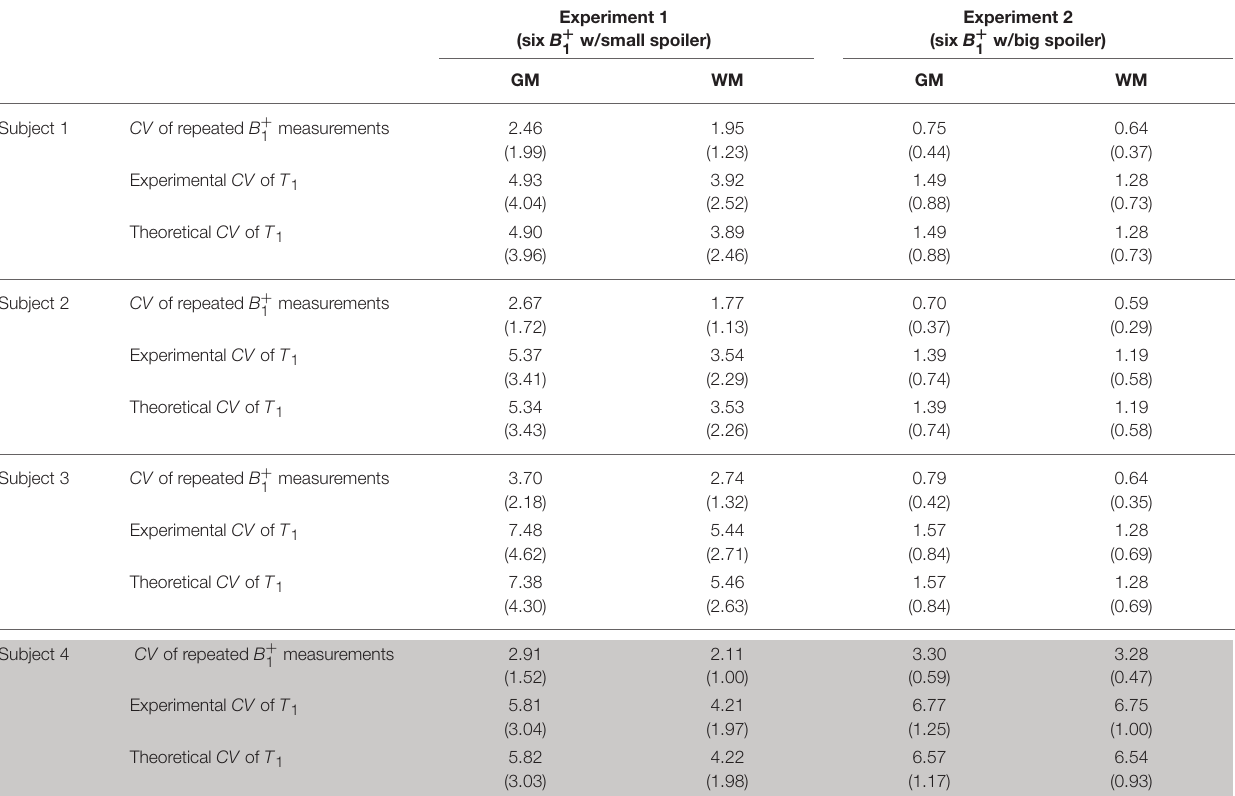
TABLE 1 | Median and (IQR) of CV values inside GM and WM for Experiments 1–2.